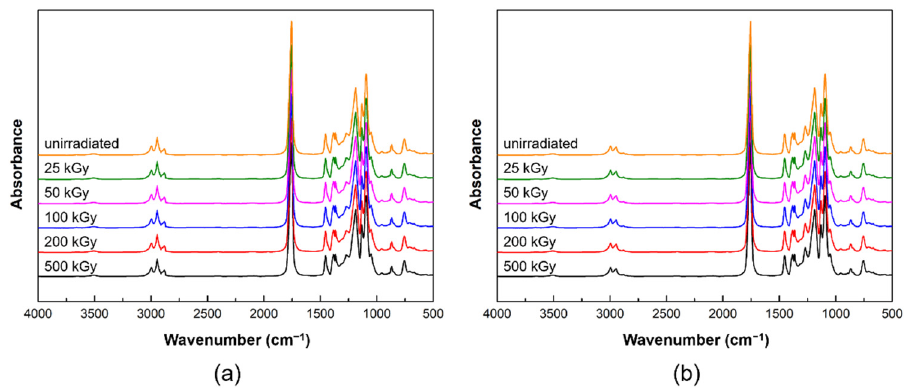
Figure 3. ATR-FTIR spectra before and after gamma-ray irradiation: ( a ) PLCL and ( b ) PLDLA polymer films.